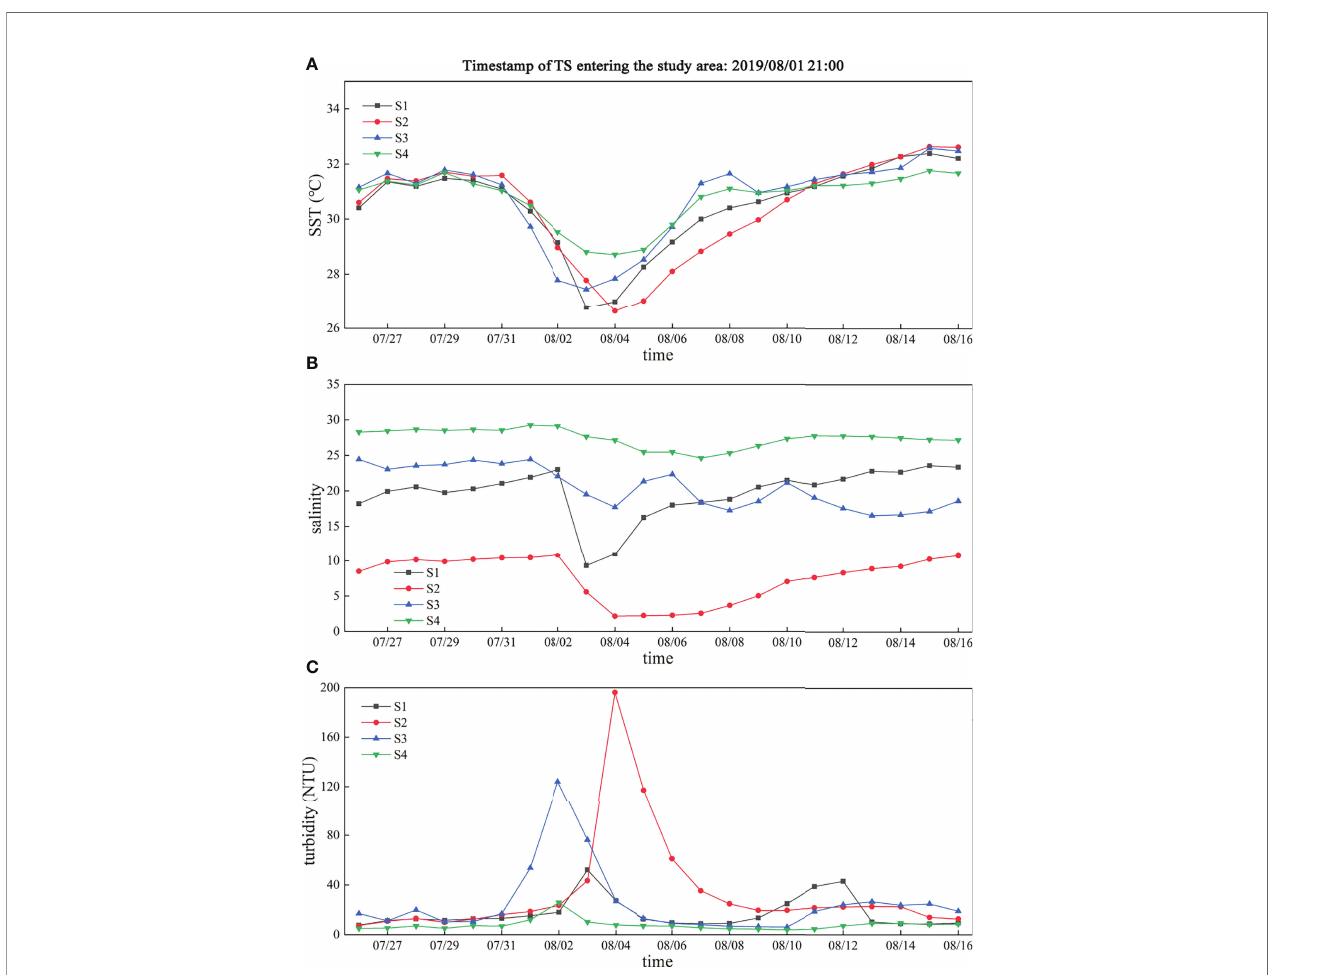
FIGURE 4 | Time series of (A) SST, (B) salinity, and (C) turbidity from July 26 to August 16, 2019.